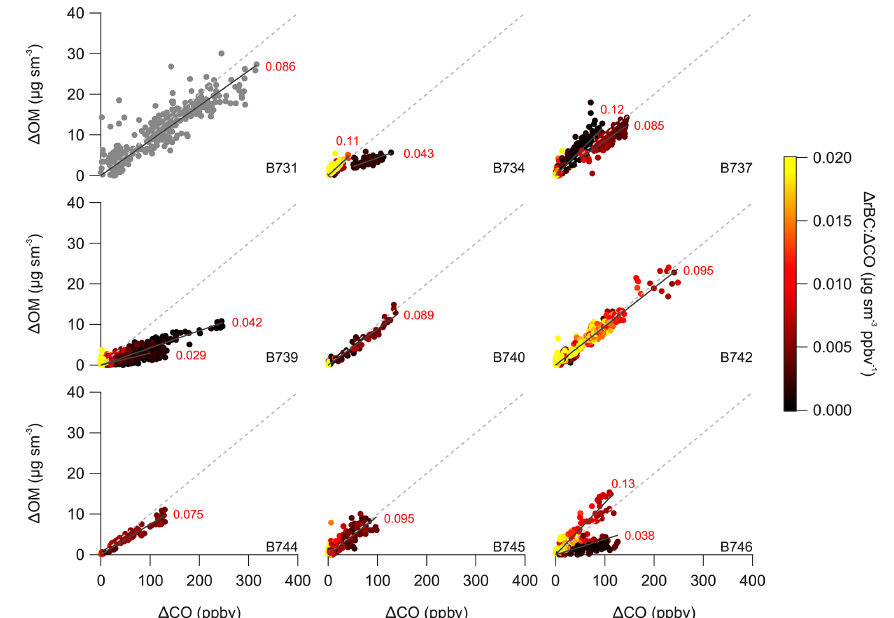
Figure 8. Comparison of organic matter (OM) with carbon monoxide (CO) across individual flights from the regional analysis. Points are coloured according to the ratio of refractory black carbon (rBC) to carbon monoxide (CO) except for B731 where limited rBC data were available. The black dashed line shows the 0.1µgsm − 3 ppbv − 1 as a consistent baseline for context across all flights, with the solid black lines showing the linear regression for either the whole flight or smaller segments where two lines are shown for a single flight. Red text next to the linear regression lines is the slope of the line of best fit in µgsm − 3 ppbv − 1